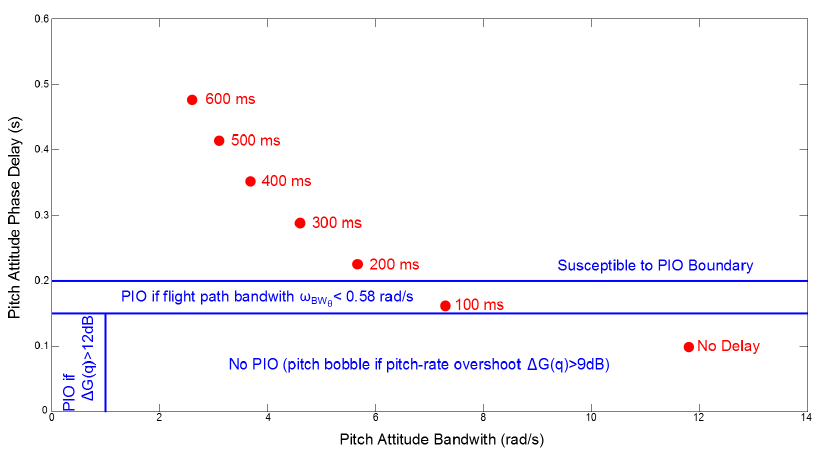
Figure 5. Plot of bandwidth and phase delay on the criteria plane